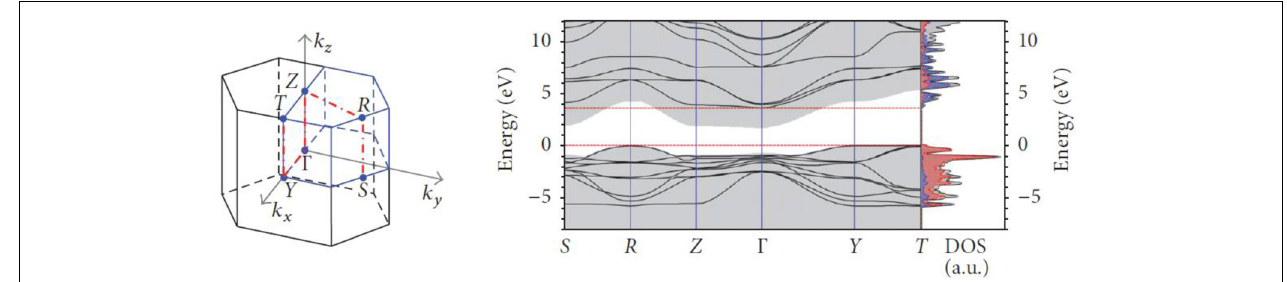
FIGURE 9 | Band structure calculated with the HSE-30 functional for the orthorhombic phases of KN, with corresponding densities of states (DOS) in arbitrary units. The gray-shaded areas indicate the PBE band structures for comparison, and the dashed horizontal lines mark the valence-band maxima and conduction-band minima. On the left-hand side, the chosen path within the first Brillouin zone is indicated by thick dash-dotted lines. [Reproduced https://doi.org/10.1155/2017/3981317, https://creativecommons.org/licenses/by/4.0/ (Schmidt et al., 2017)].